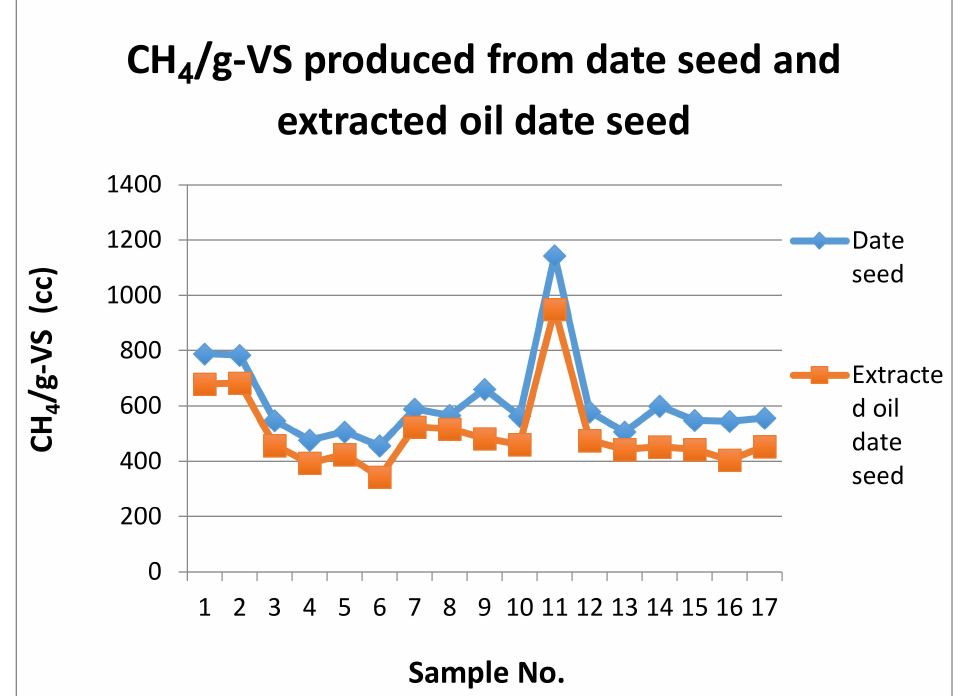
Figure 42. CH 4 /g-VS yields before and after date seed oil extraction.